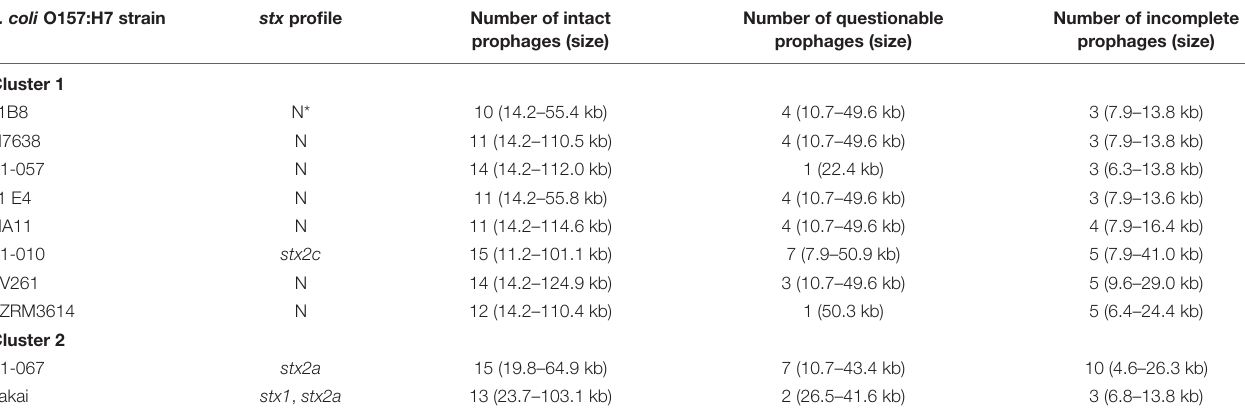
Number of questionable Number of incomplete prophages (size) prophages (size) prophages